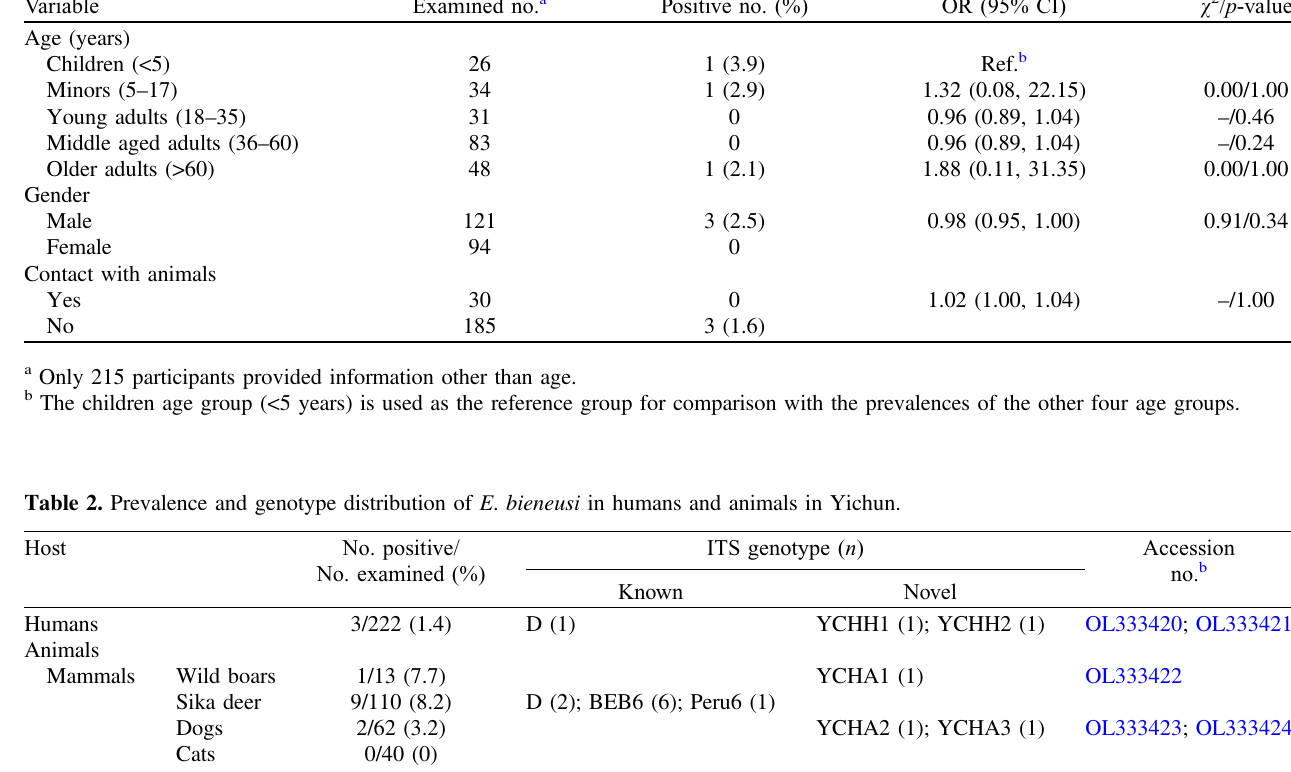
Table 1. Assessment of possible risk factors for human E . bieneusi infection in Yichun. Variable